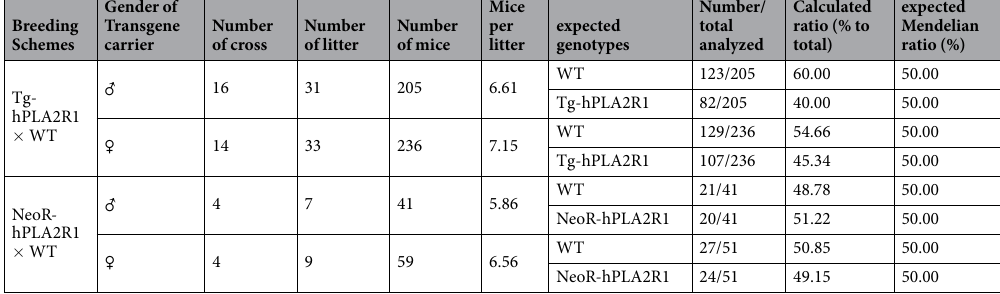
Table 1. Progeny analysis and Mendelian repartition of WT × Tg-hPLA2R1 or WT x NeoR-hPLA2R1